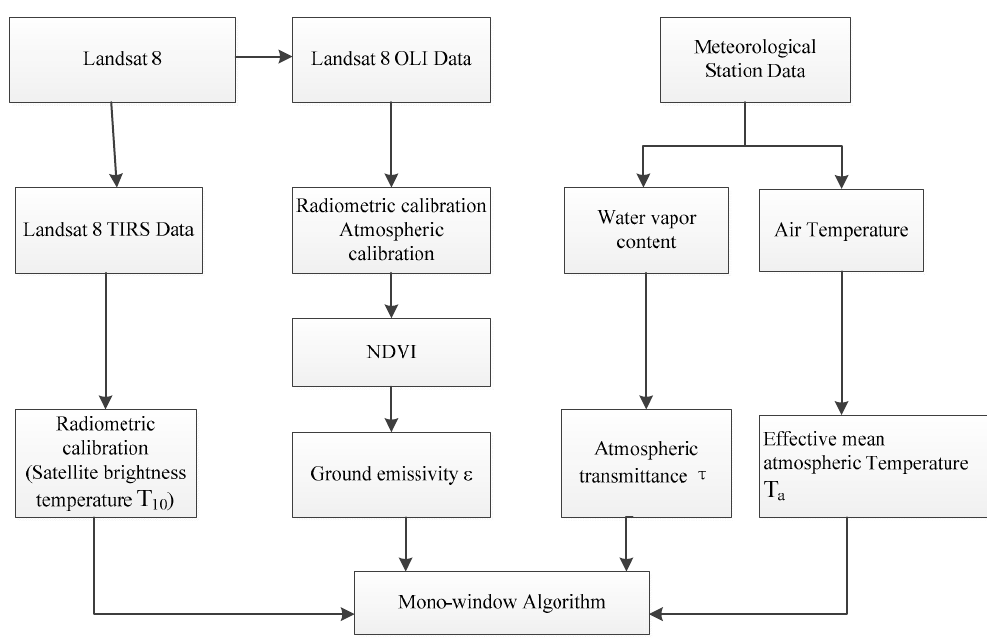
Figure 2. Flow chart of the mono-window algorithm.